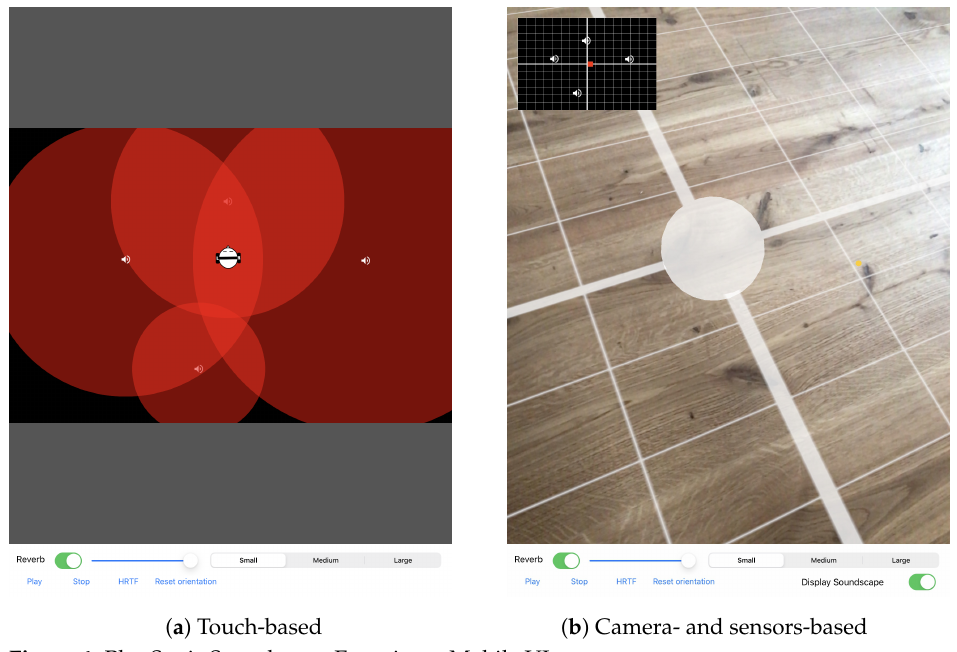
Figure 4. PlugSonic Soundscape Experience Mobile